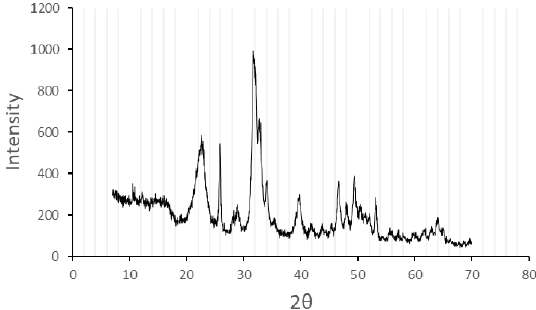
Figure 7. XRD of the cellulose-hydroxyapatite composite membrane (Cu K α ).